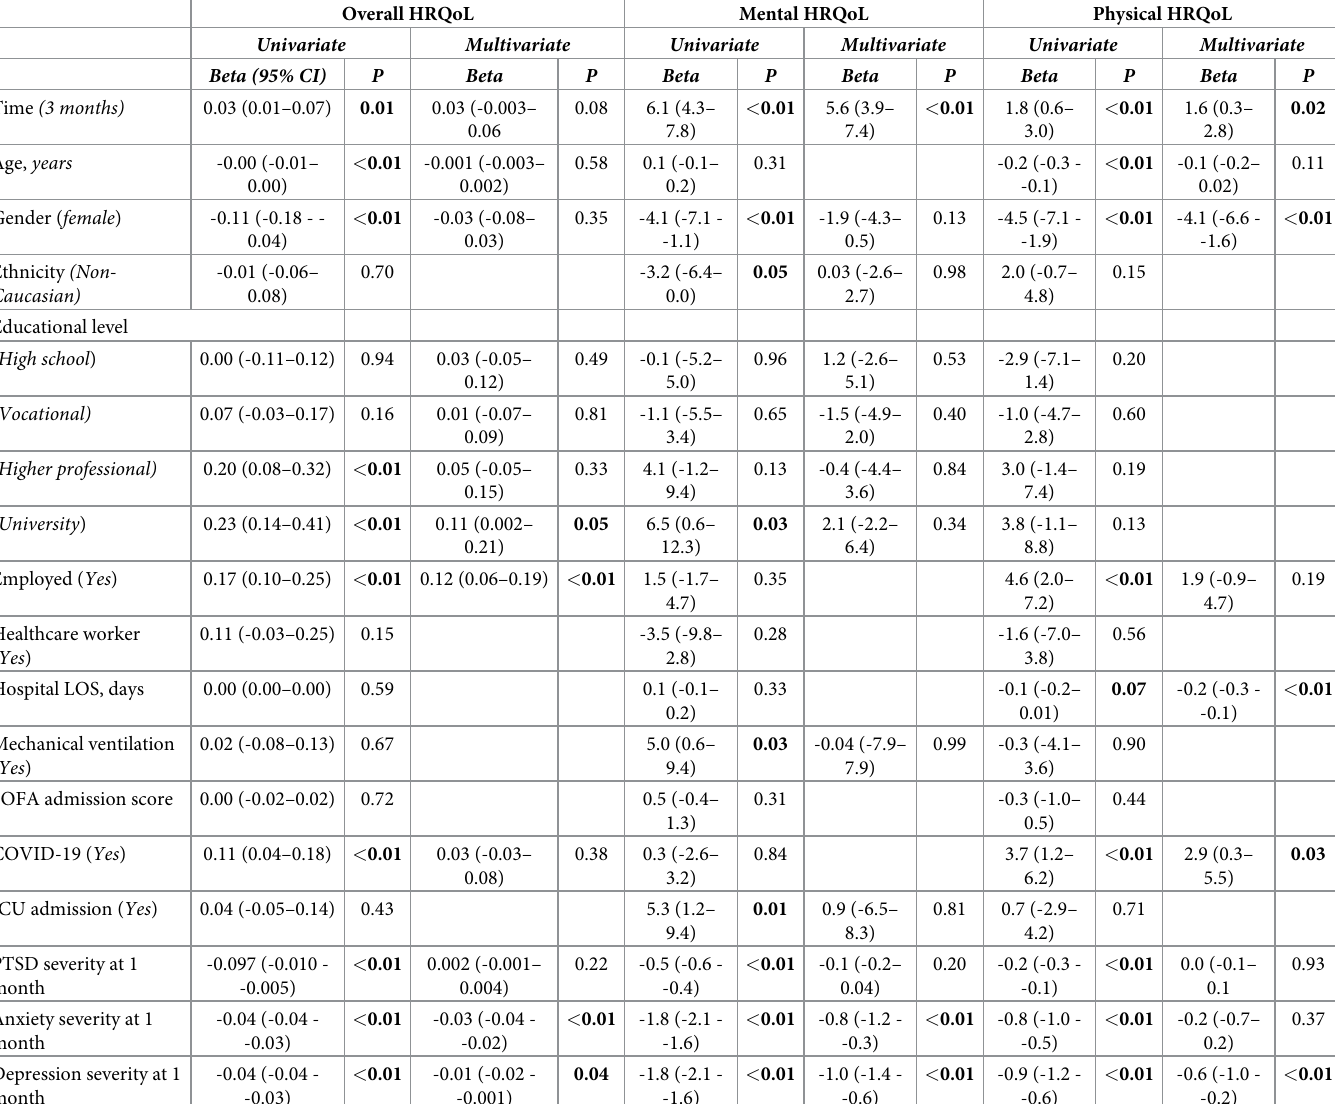
Table 5. Predictors for the overall HRQol, the mental quality of life, and the physical quality of life. Overall